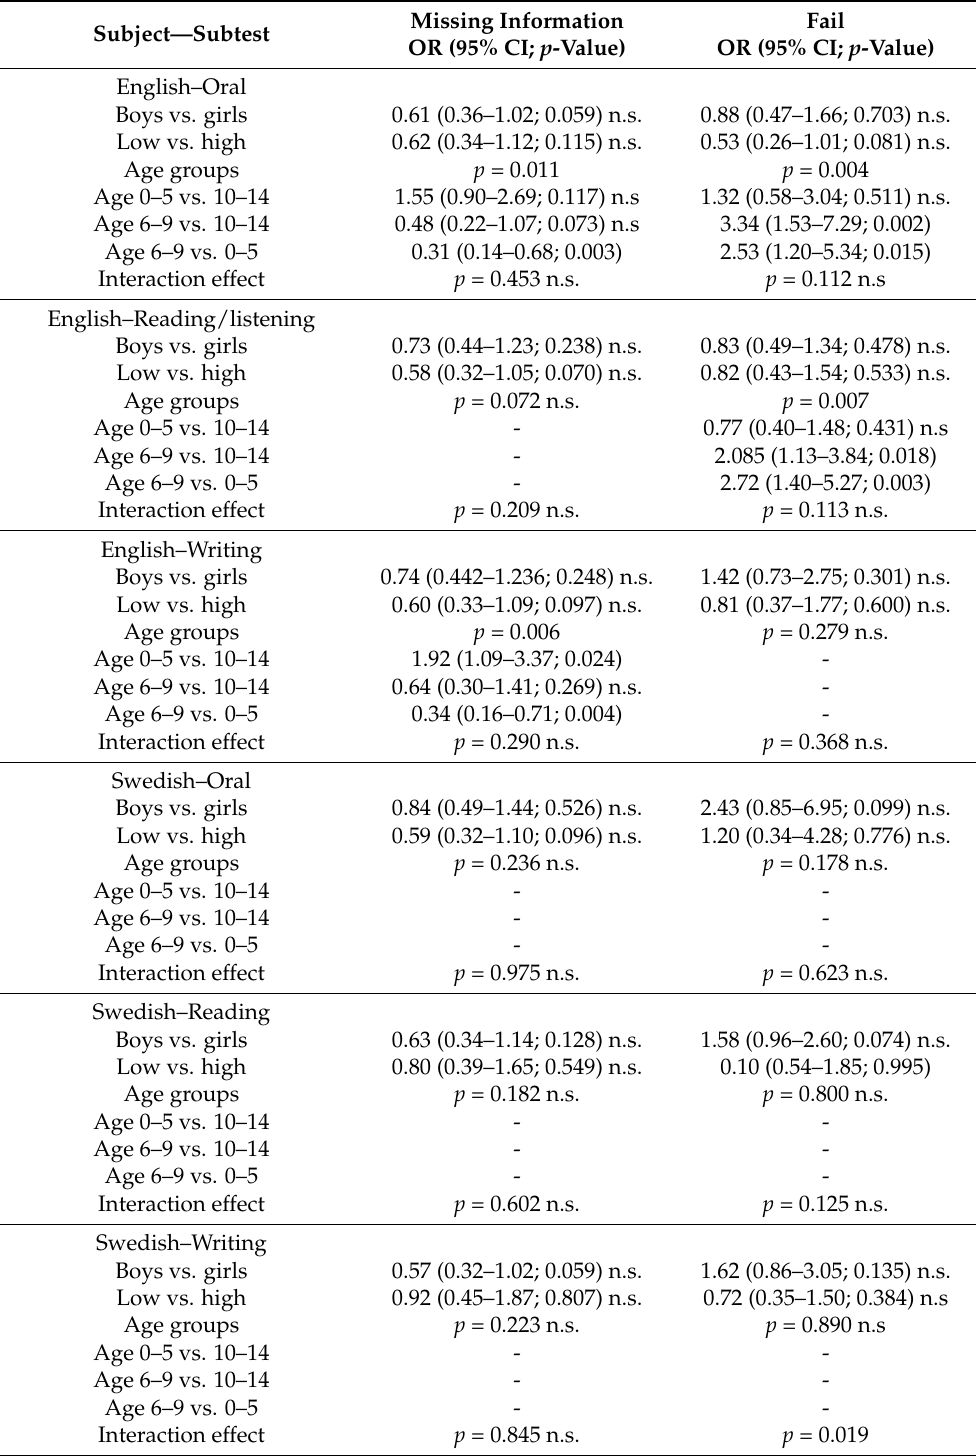
Table 8. Odds ratios (OR) 95%, confidence intervals (95% CI) and p -values regarding missing information and fail for differences between boys and girls, high- and low-grade tumours and age groups. Interaction effect between sex and age at diagnosis is also reported. Differences between age groups are only presented when there was an overall significant difference for the age groups. n.s. = not